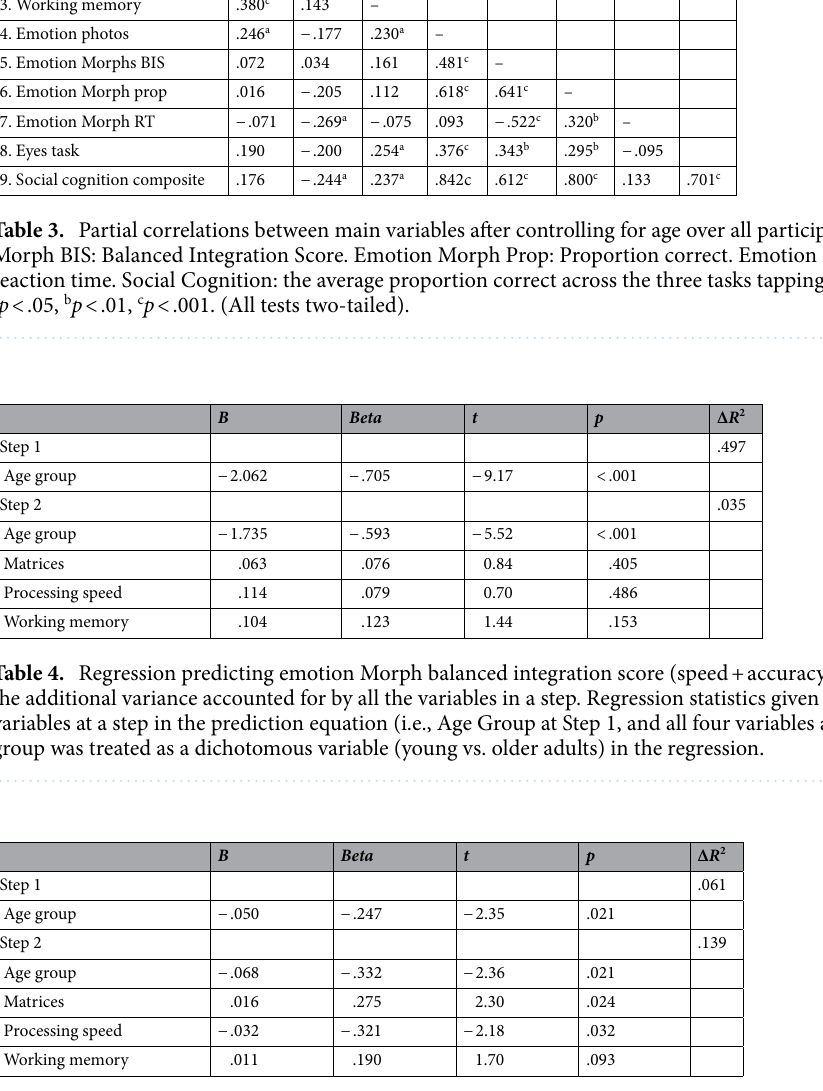
Table 5. Regression predicting emotion photos performance. Δ R 2 represents the additional variance counted for by all the variables in a step. Regression statistics given with relevant variables at a step in the prediction equation. Age group was treated as a dichotomous variable (young vs. older adults) in the regression.